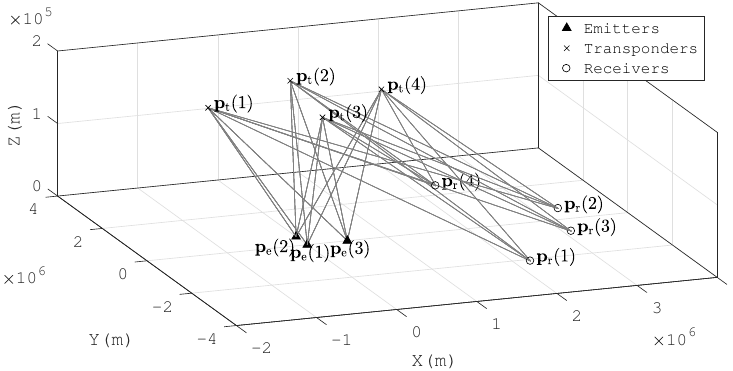
Figure 1. Multiple-path positioning problem with static